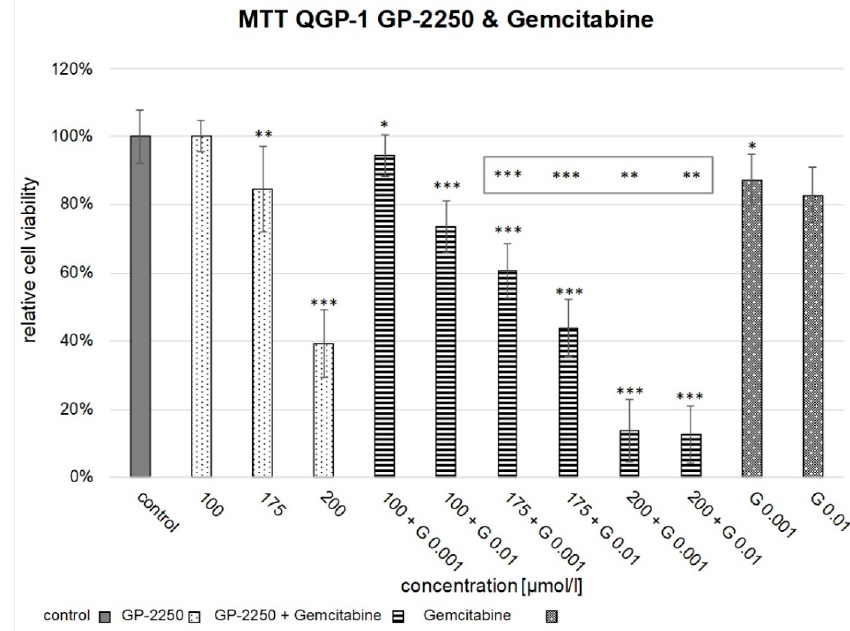
Figure 2. Cell viability assay of combination therapy in QGP-1. Figure 2 shows the reduction in cell viability observed in the MTT assay of the combination therapy of 100 µM GP-2250 + 0.001